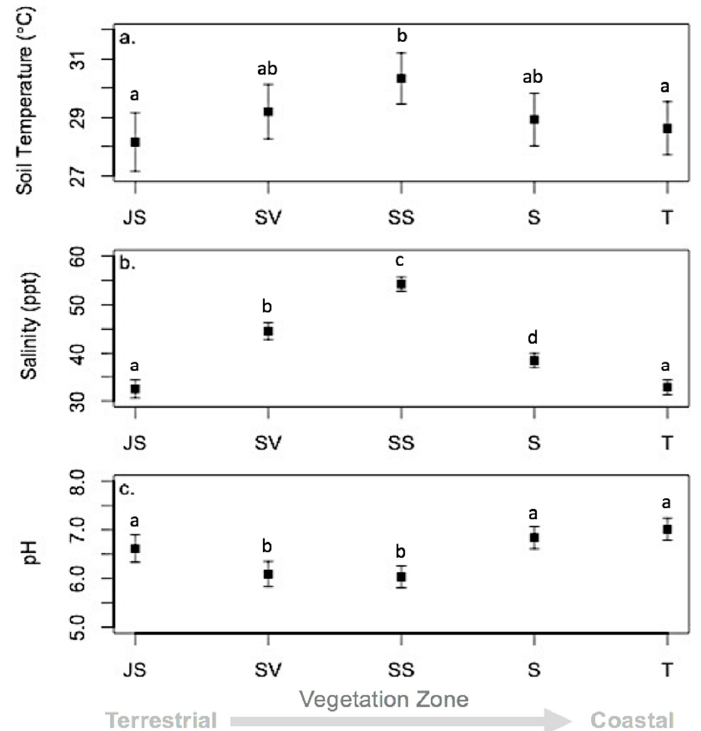
Figure 7. Environmental conditions least square means by vegetation zone. ( a ) Soil Temperature (°C); ( b ) salinity (ppt); and ( c ) pH. (JS = high marsh Juncus roemerianus ; S = low marsh short form S. alterniflora ; SV = high marsh Salicornia virginica ; SS = mid ‐ marsh mixed zone of co ‐ occurring S. virginica and short form Spartina alterniflora ; T = low marsh tall form S. alterniflora ). Letters denote significant differences between vegetation zones; zones with the same letters are similar to each other but significantly different from zones designated by different letters. Error bars denote standard errors.